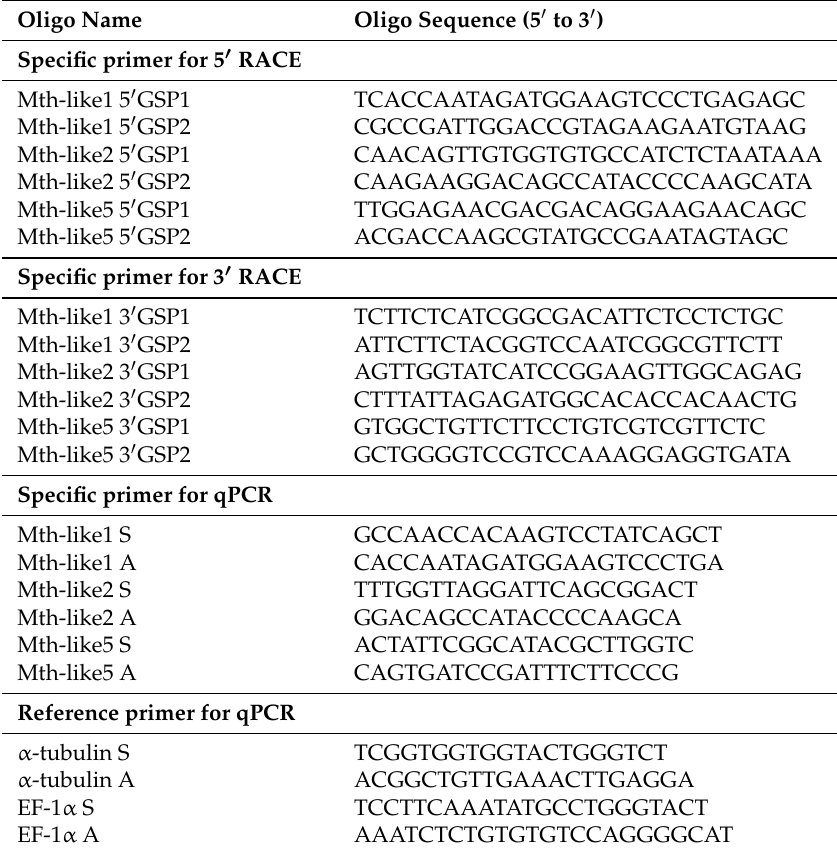
Table 1. Gene-specific primers used for rapid amplification of cDNA ends and real-time quantitative PCR of Dastarcus helophoroides mth-like